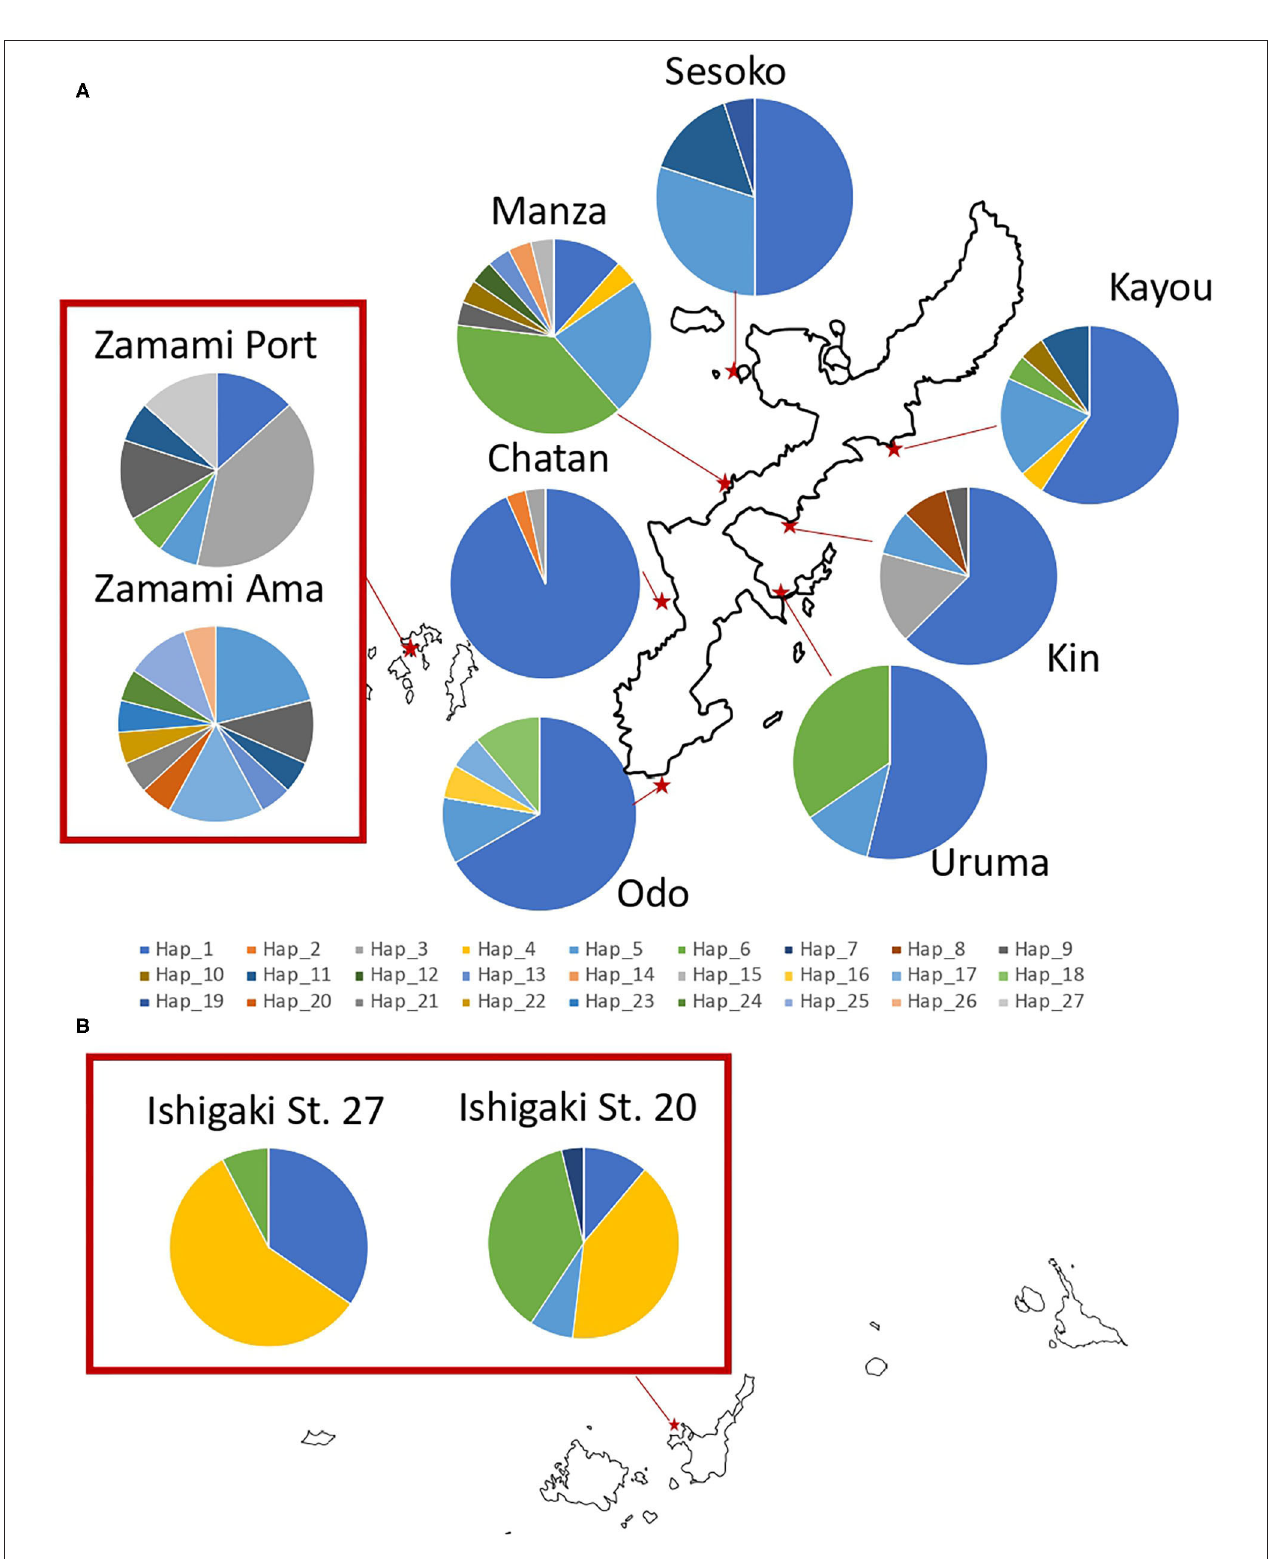
FIGURE 2 | Sampling locations of H. atra with the proportion of each COI haplotype in (A) Okinawajima Island and the Kerama Islands, and (B) Ishigaki Island. Each color indicates a different haplotype.